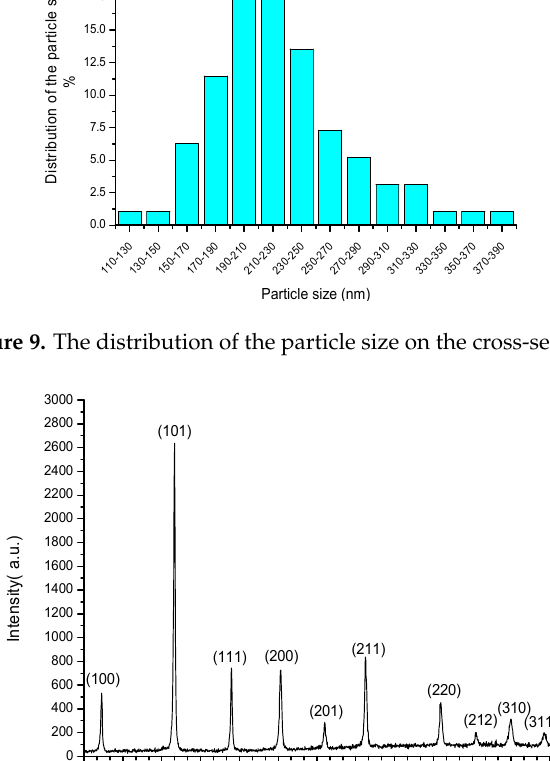
Figure 10. XRD pattern of the BTO film sintered at 900 °C for 2 h.